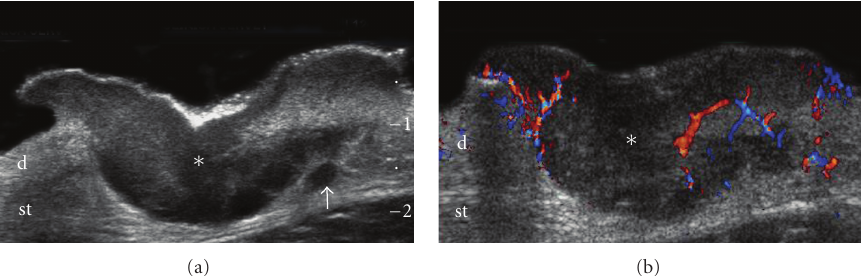
Figure 3: Bulky melanoma at the abdominal wall. (a) Ultrasound (transverse view) shows fusiform hypoechoic lesion ( ∗ ) infiltrating dermis and subcutaneous tissue. Notice the hypoechoic solid nodule besides the primary tumor that corresponds to a satellite metastasis (arrow). (b) Color Doppler ultrasound demonstrates increased blood flow within the lesion. Abbreviations: d: dermis; st: subcutaneous tissue.